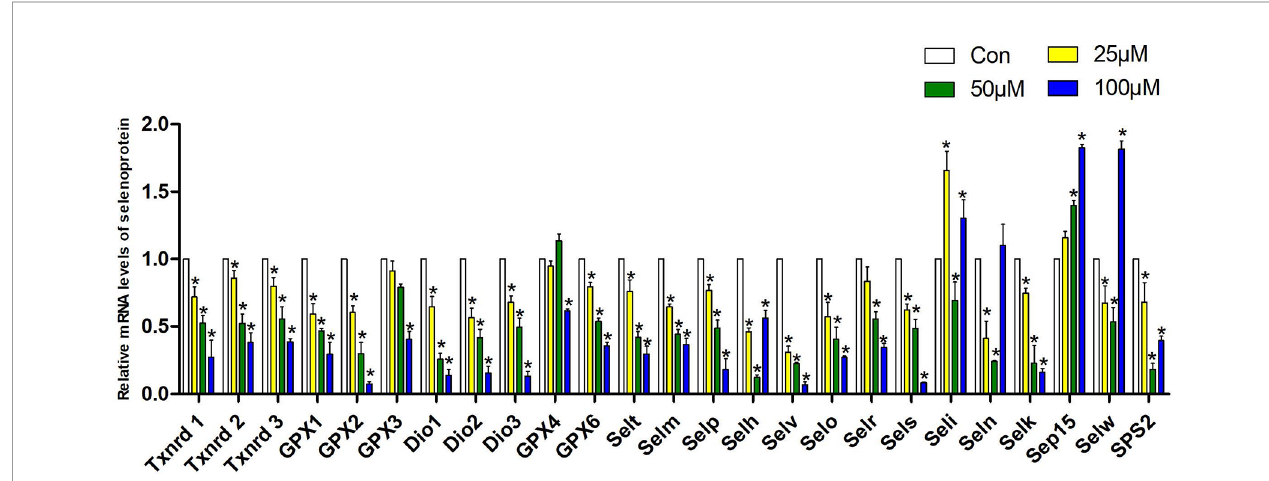
FIGURE 6 | Effects of Sch B on the expression of selenoprotein mRNA levels in Hepa1-6 cells. The 25 selenoprotein mRNA levels with 0-, 25-, 50-, and 100- m M Sch B treatment in Hepa1-6 cells. ∗ shows a signi fi cant difference from the corresponding control ( P < 0.05). n = 3.